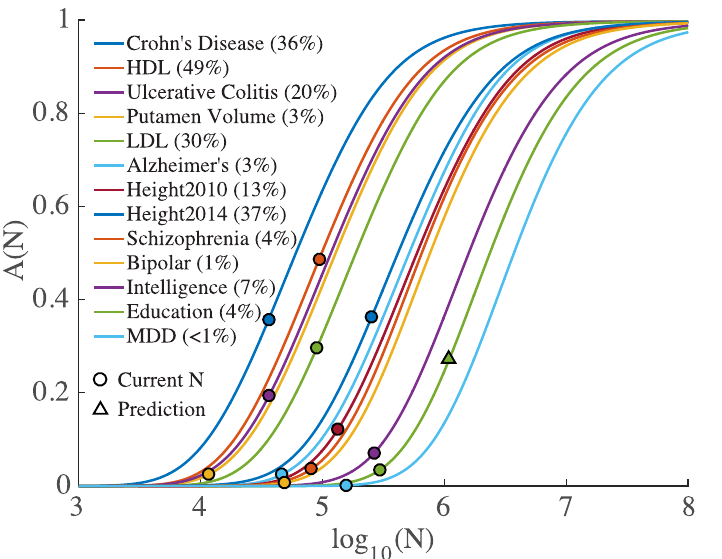
Fig 3. Proportion of narrow-sense chip heritability, A ( N ) (Eq 37), captured by genome-wide significant SNPs as a function of sample size, N , for phenotypes shown in Figs 1 and Fig 2. Values for current sample sizes are shown in parentheses. Left-to-right curve order is determined by decreasing s 2 . The prediction for education at sample size b N = 1.1 million is A ( N ) = 0.27, so that the proportion of phenotypic variance explained is predicted to be 3.5%, in good agreement with 3.2% reported in [70]. (The curve for AD excludes the APOE locus. For HDL, see S1 Appendix (p. S9) for additional